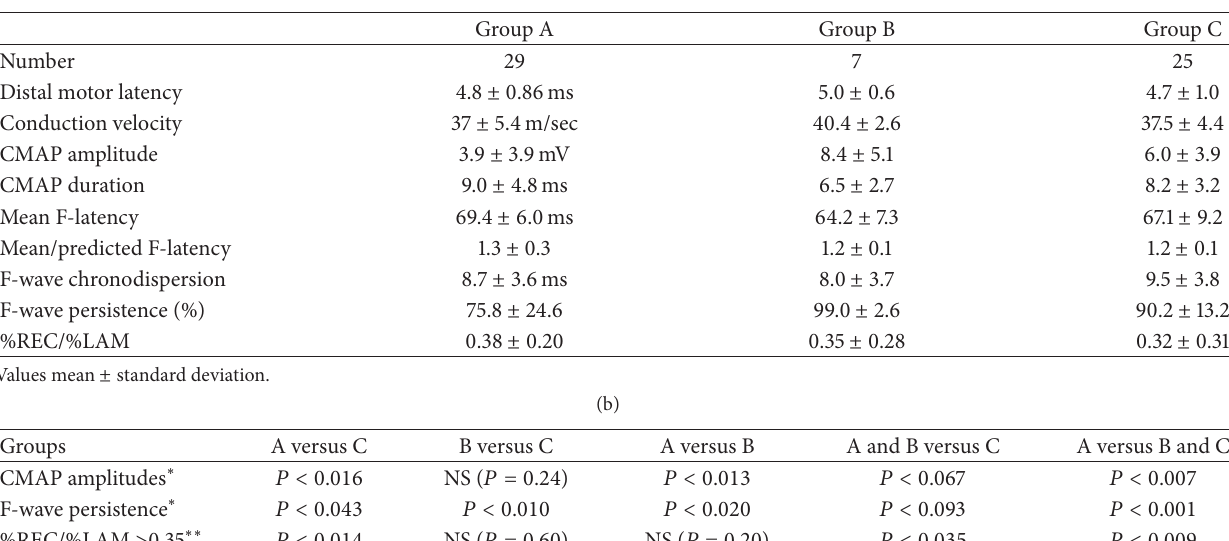
Table 1: Electrodiagnostic variables in the three groups of patients as well as %REC/%LAM values and statistical differences between groups.